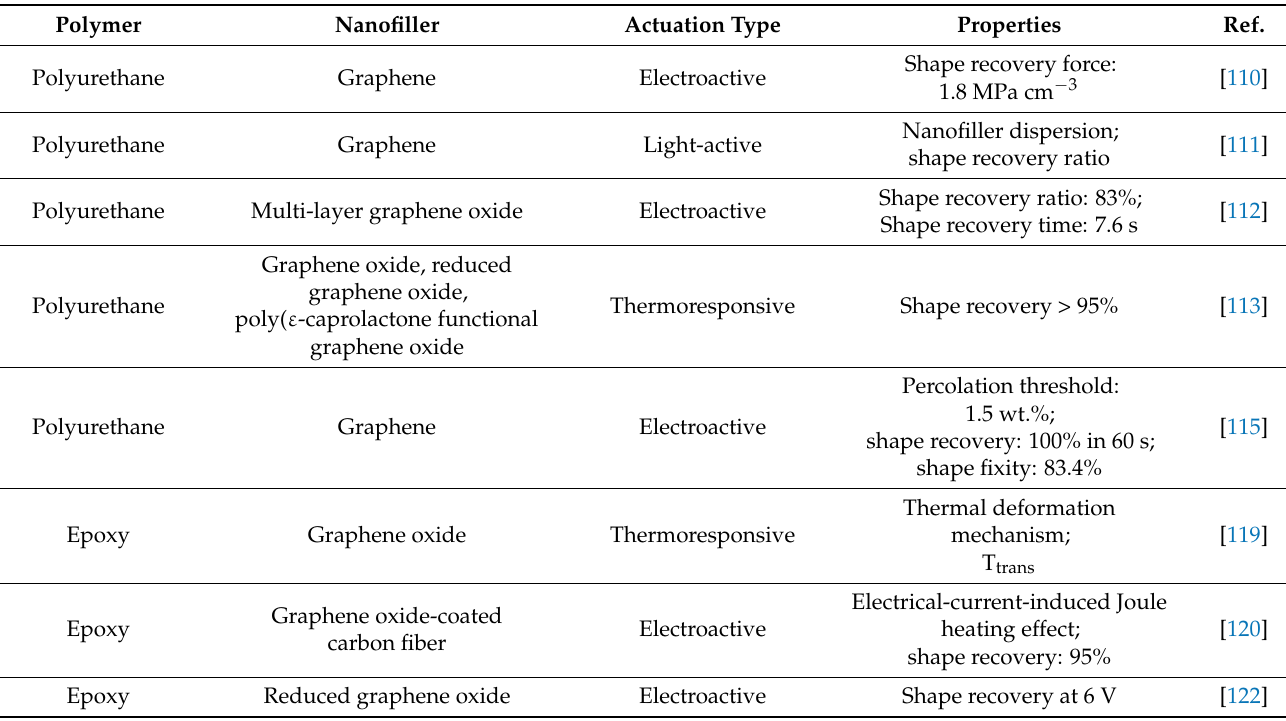
Table 3. Shape memory effect in graphene-based